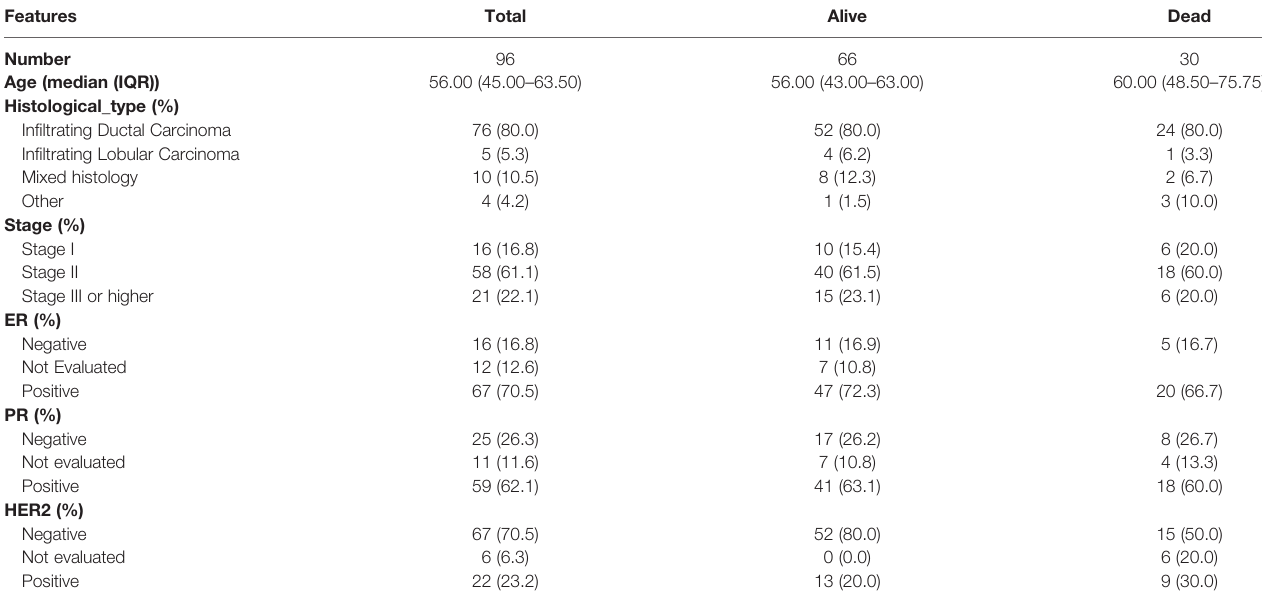
TABLE 1 | Clinical characteristics of 96